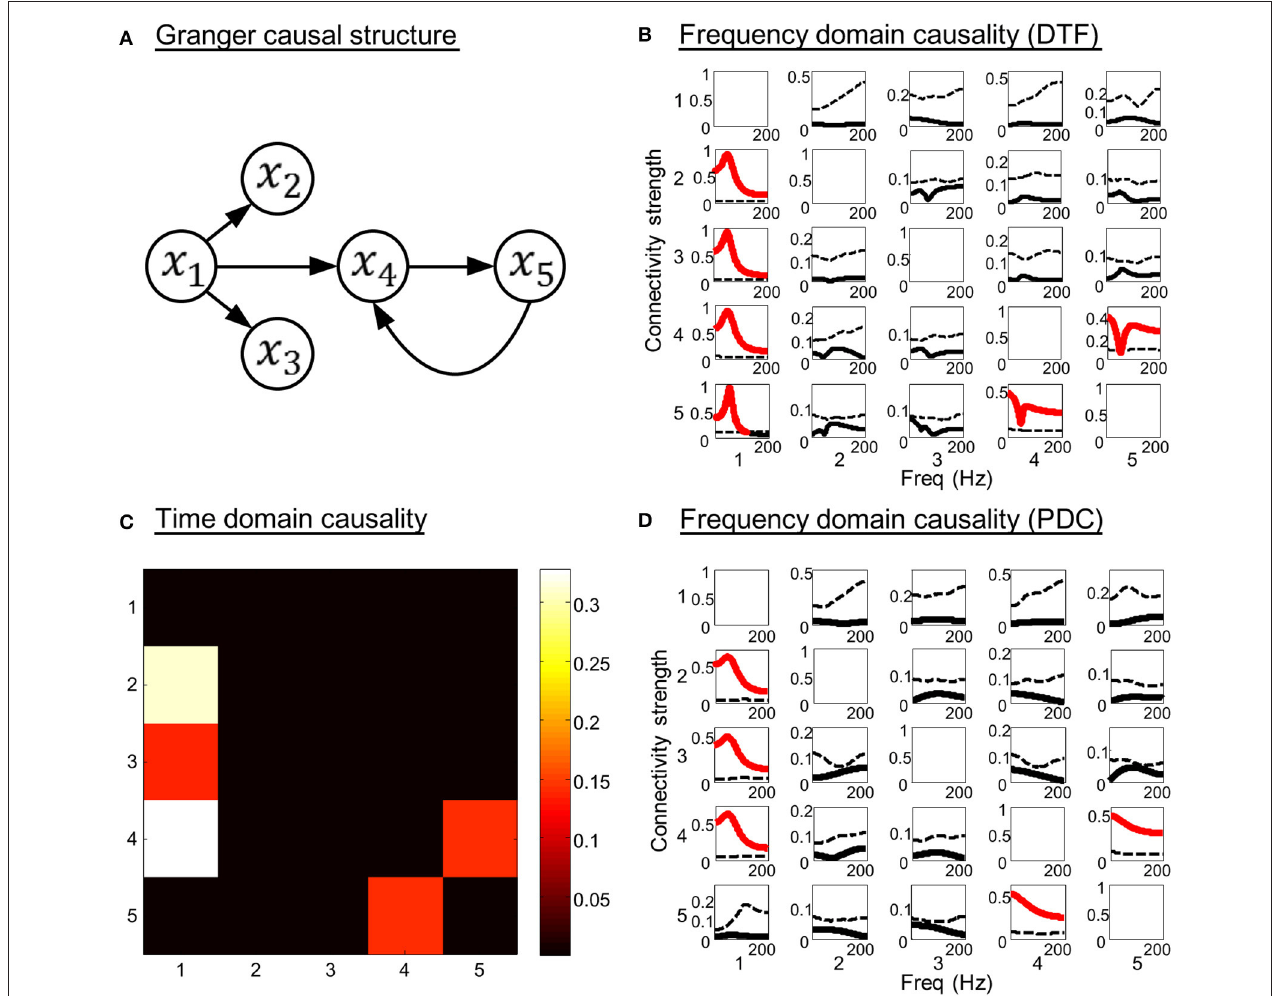
FIGURE 3 | Simulation results of toy model 2. (A) Granger causal structure of the variables. (B) The spectrum of significance thresholds (black dotted line) and directed transfer function (DTF) values (black solid line, values greater than the thresholds are highlighted in red). (C) The colormap of partial Granger causality values in time domain analysis. (D) The spectrum of significance thresholds (black dotted line) and partial directed coherence (PDC) values (black solid line, values greater than the thresholds are highlighted in red) in frequency domain analysis. Note: in (B–D) the direction of causality is from column to